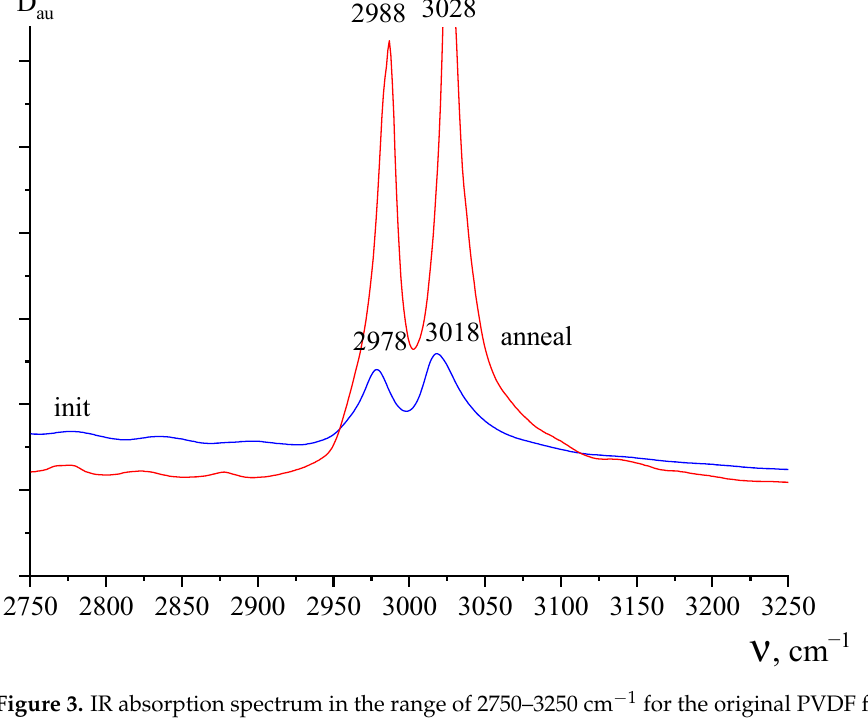
Figure 3. IR absorption spectrum in the range of 2750–3250 cm − 1 for the original PVDF film (initial) and after heating to 200 °C (annealing).